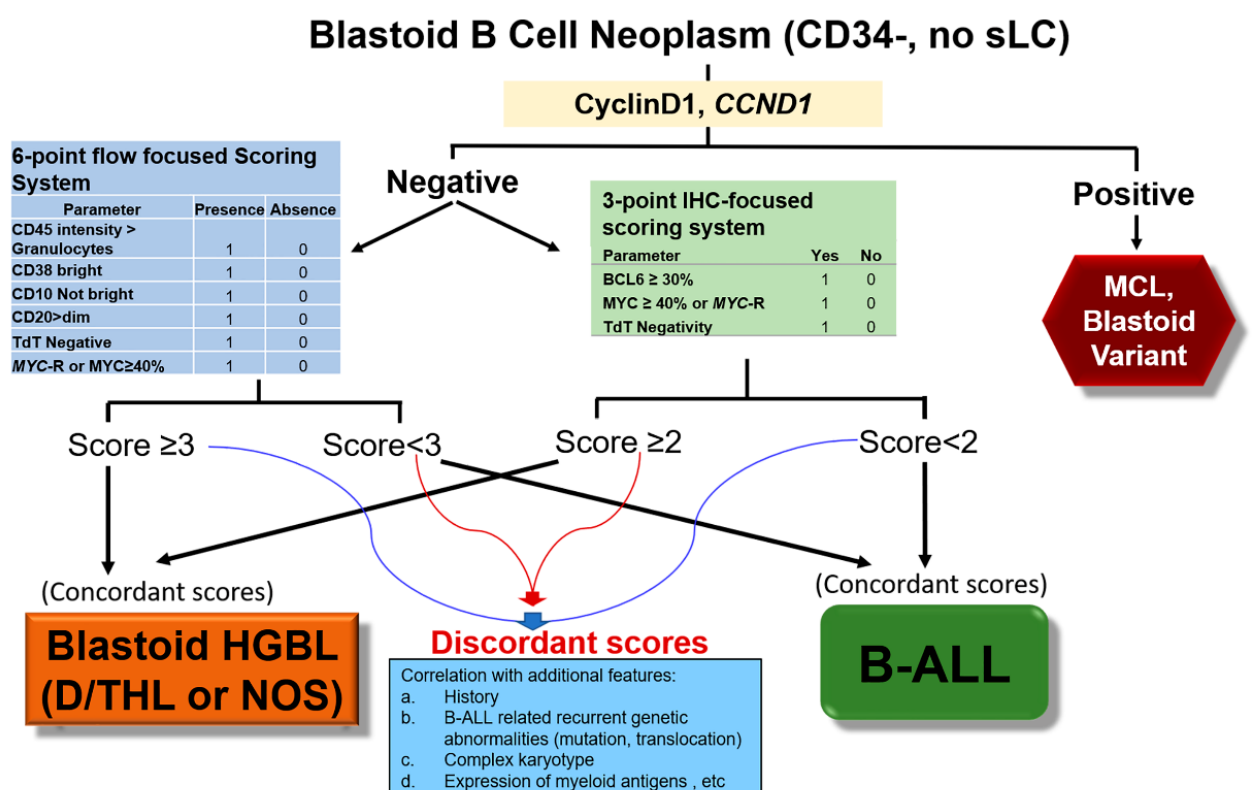
Figure 5. Recommended algorithm for the differential diagnosis of blastoid B-cell neoplasm, HGBL, high-grade B-cell lymphoma, B-ALL, B-acute lymphoblastic leukemia/lymphoma, MCL, mantle cell lymphoma. The thin blue and red lines were used for different combinations for discordantly scored cases between the two scoring systems.